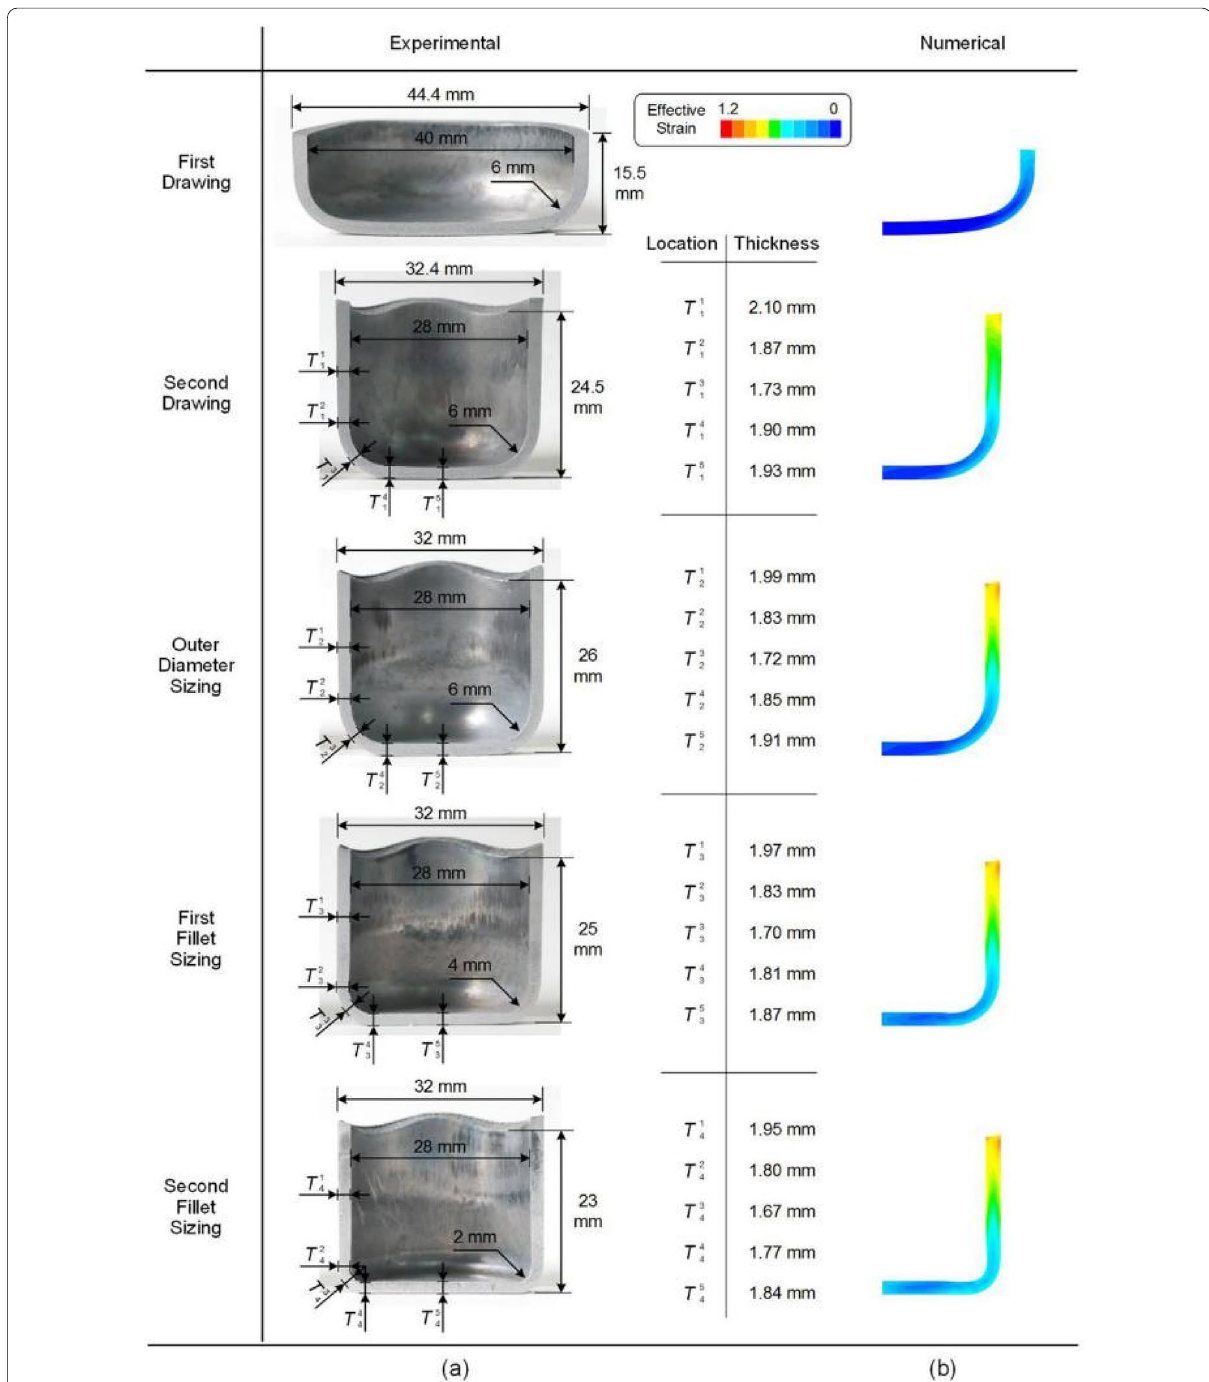
Figure 9 Sheet forming results in terms of thickness distribution: ( a ) experimental; ( b )